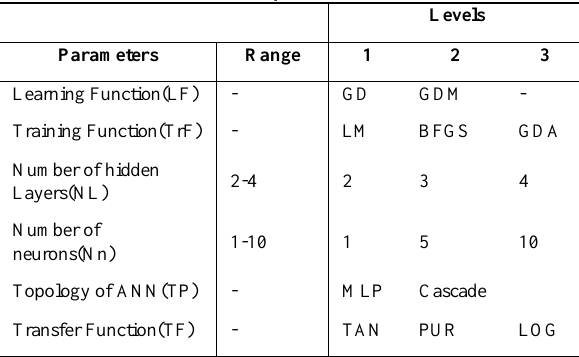
Table 2. ANN parameters levels.